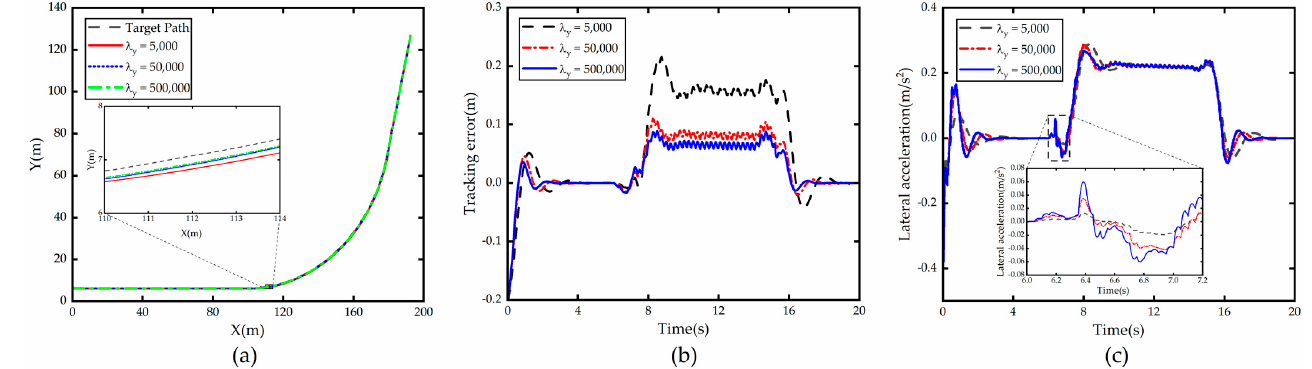
λ .( a ) Path; ( b ) Tracking error; ( c ) Lateral y